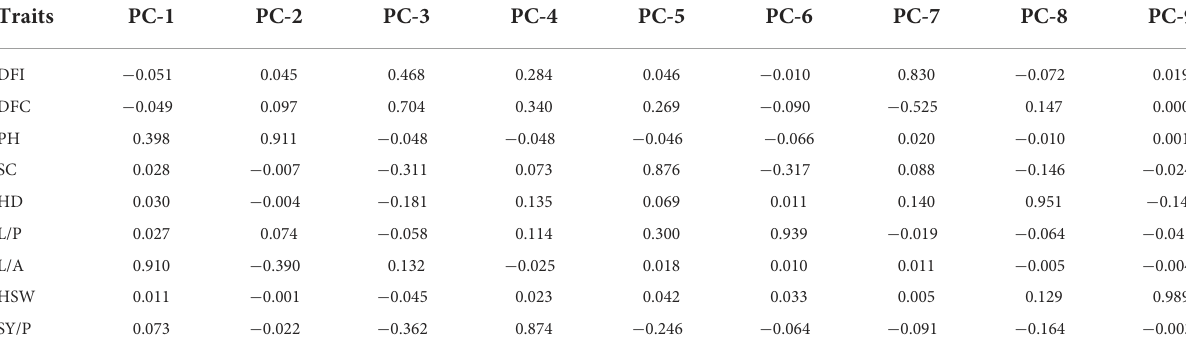
TABLE 3 Factor loadings of various morphological traits toward nine principal components of 109 sunflower genotypes.